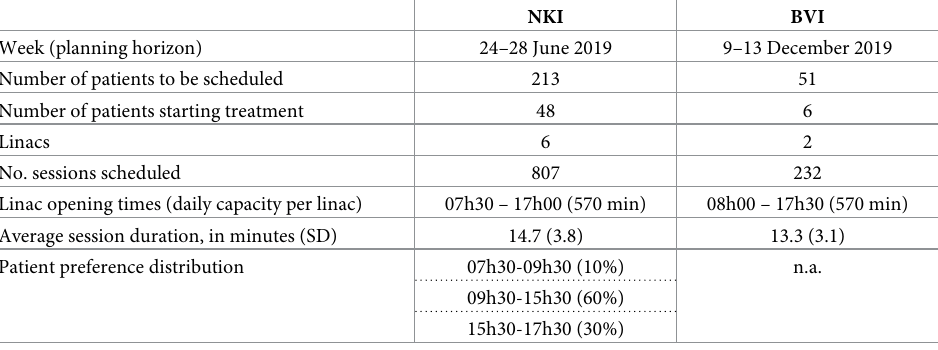
Table 1. Data used as model inputs for the computational experiments of each